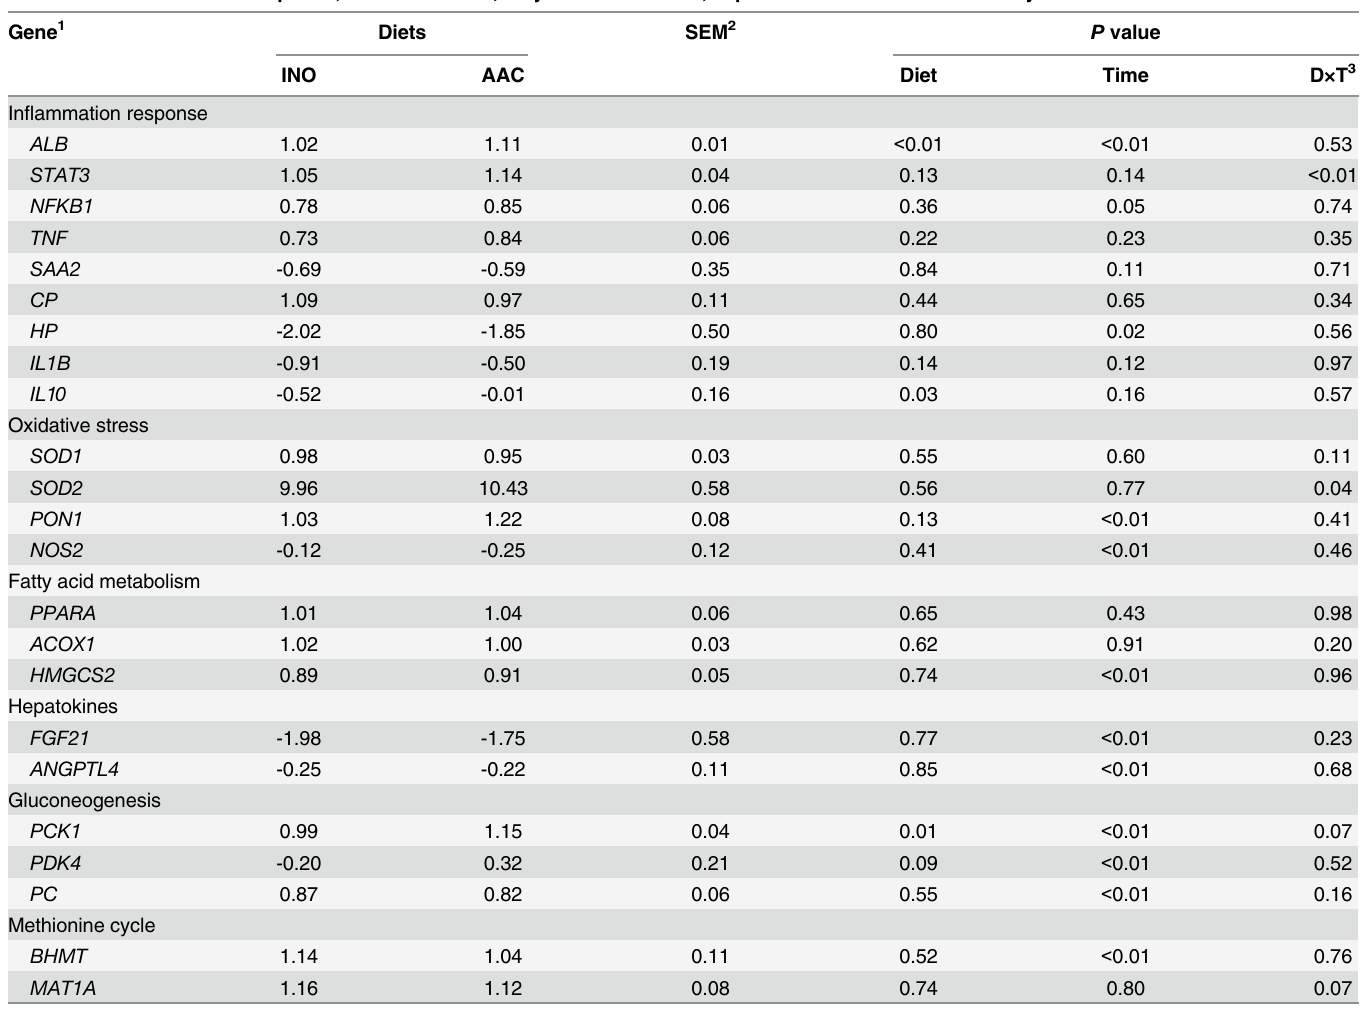
( P = 0.07) for a D × T because its expression increased over time, primarily at 10 d ( P < 0.01) postpartum, in AAC cows compared with INO ( Table 2 and Fig 6 ). There was an overall ten- dency ( P = 0.09) for greater expression of PDK4 , another gluconeogenic gene, in cows fed AAC compared with INO. The expression of the methionine cycle gene MAT1A had a tendency for a D × T ( P = 0.07) because of a lower ( P = 0.03) expression at d 10 in cows fed AAC compared with INO ( Table 2 and Fig 5 ). The expression of HMGCS2 (ketogenesis), FGF21 and ANGPTL4 (hepatokines), PC (gluconeogenesis) and BHMT (methionine cycle) had a time effect ( P < 0.01) due to greater expression at d 10. Table 2. Effects of supplementing cows with inorganic (INO) or organic (AAC) trace minerals during the peripartal period on expression of genes related with inflammation response, oxidative stress, fatty acid metabolism, hepatokines and the methionine cycle. Gene